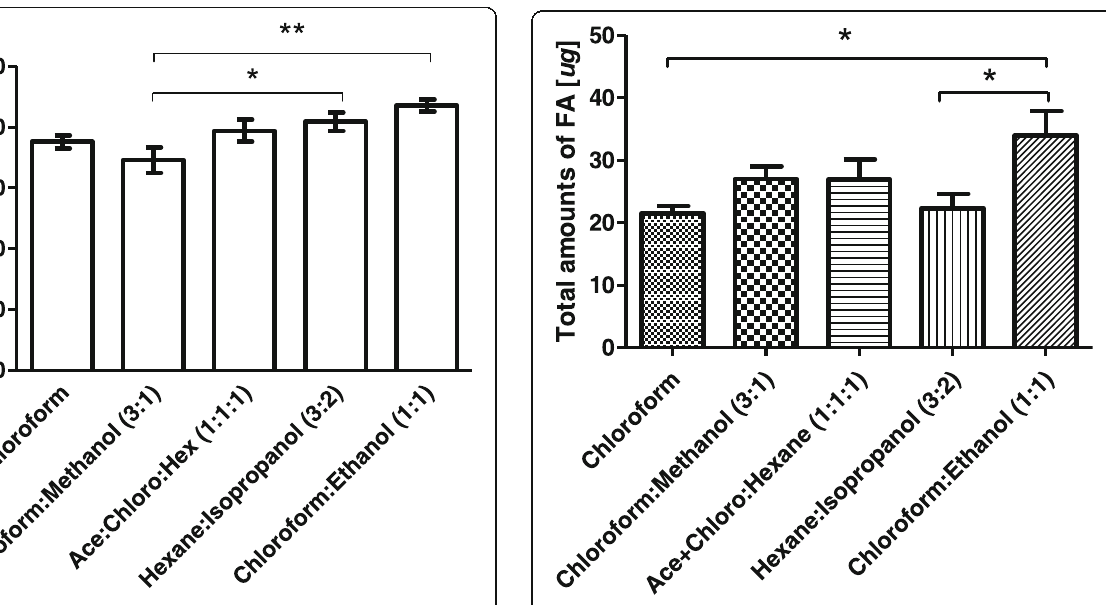
Fig. 3 Recovery ratio of C11 by using different organic solvents (% of total fatty acids). Data are represented as means ± SEM. The p value is 0.0027 ( n = 10). The two asterisks and one asterisk indicate 0.001 ≤ p < 0.01 and 0.01 ≤ p < 0.05, respectively